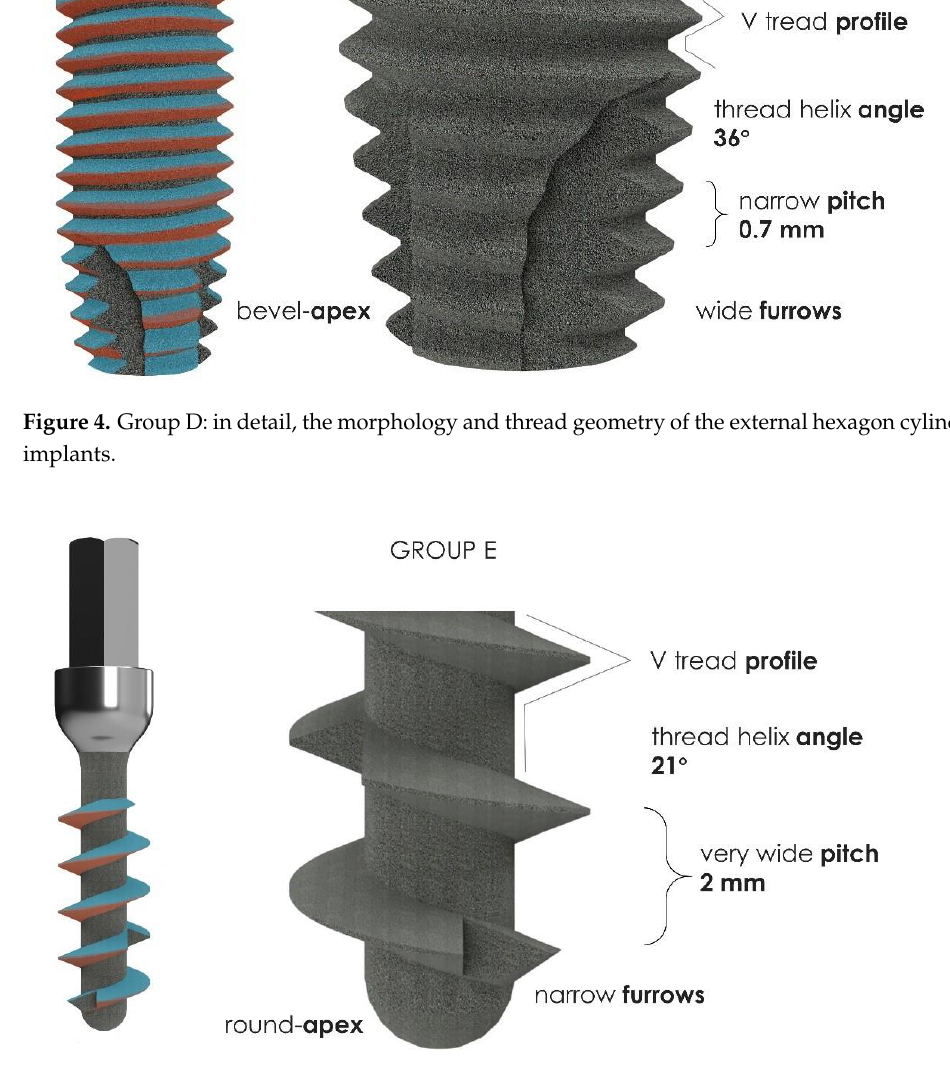
Figure 5. Group E: in detail, the morphology and thread geometry of the one-stage screw im- plants.